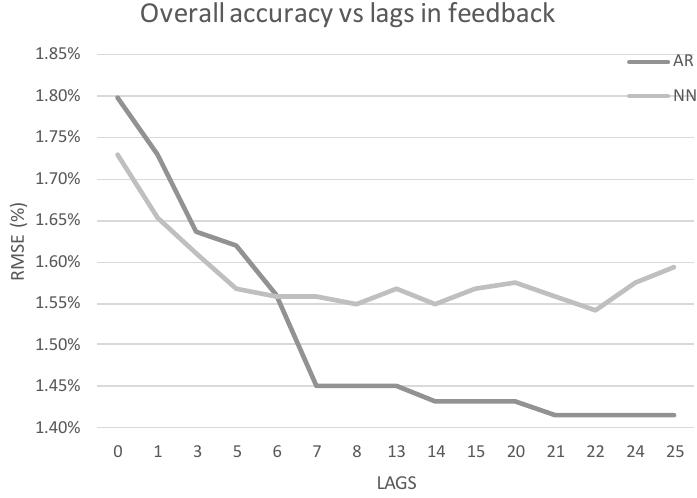
Figure 14. Overall forecasting error (RMSE) with different lagged feedback.